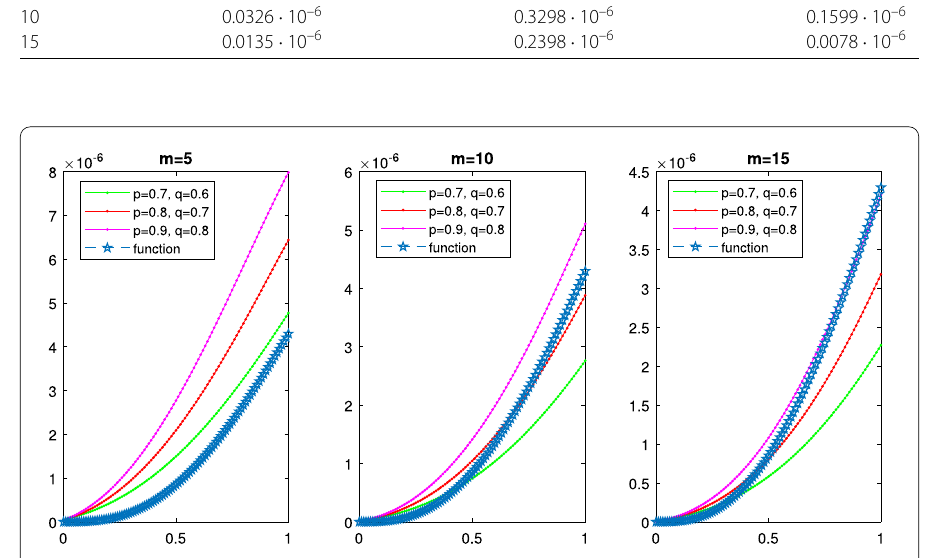
Figure 1 Convergence of ( p , q )-analogue Lupa¸s–Schurer–Kantorovich operators K ( p , q ) m , s ( f ; x ) for various values of p ,1 and m with fixed s =